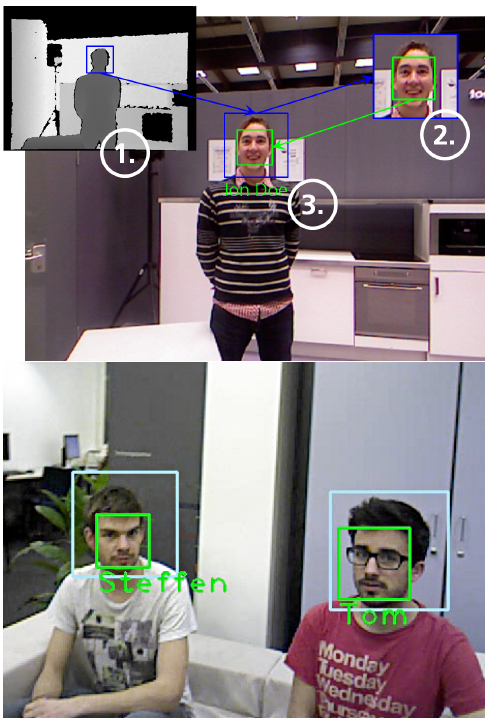
Figure 9. Person identification in three steps: 1. detection of a head in the depth image (blue frame), 2. detection of a face in the color image (green frame), and 3. the identification of the